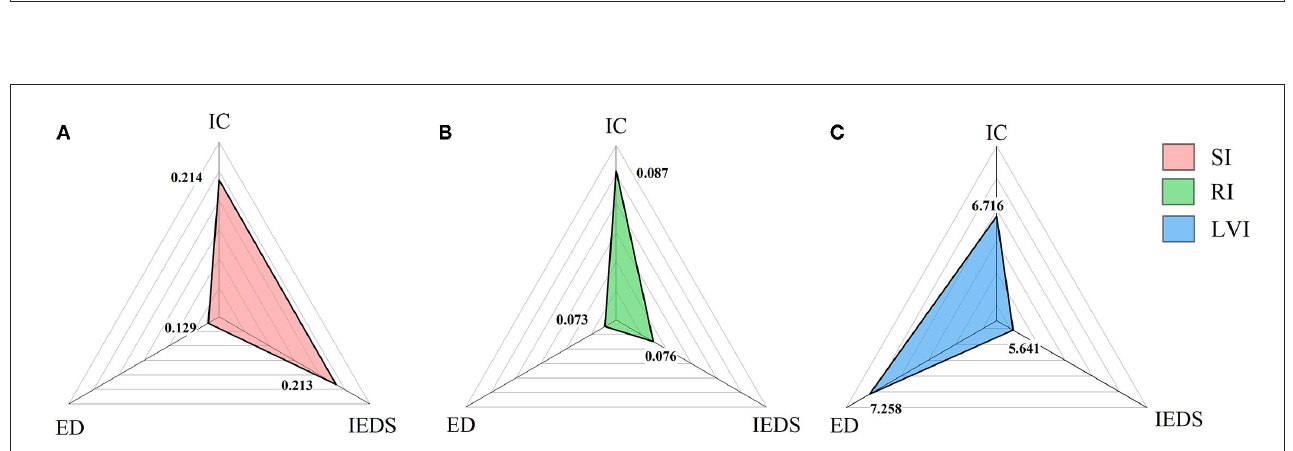
FIGURE6 (A) Levels of sensitivity index, (B) responsiveness index, and (C) livelihood vulnerability index. The three corners of each radar plot represent each of the three farmer